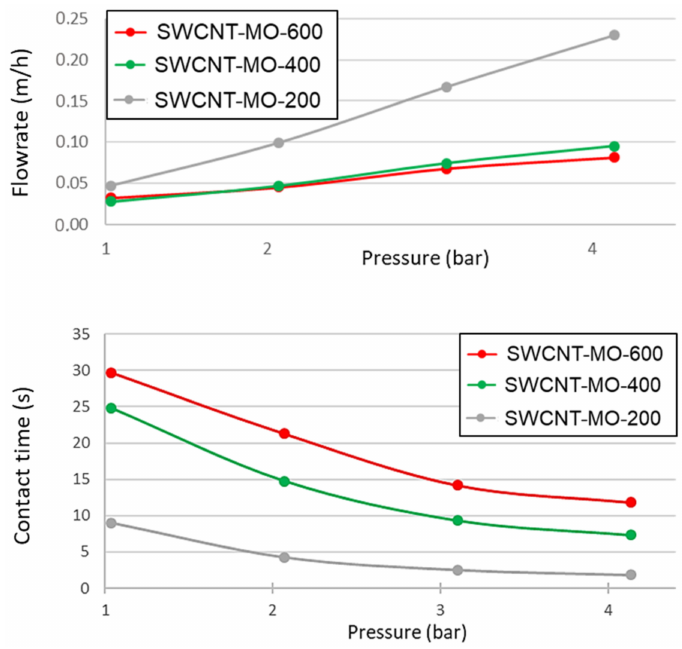
Figure 11. Flow rate and contact time of SWCNT-MO-200, SWCNT-MO-400, and SWCNT-MO-600 membranes as a function of the